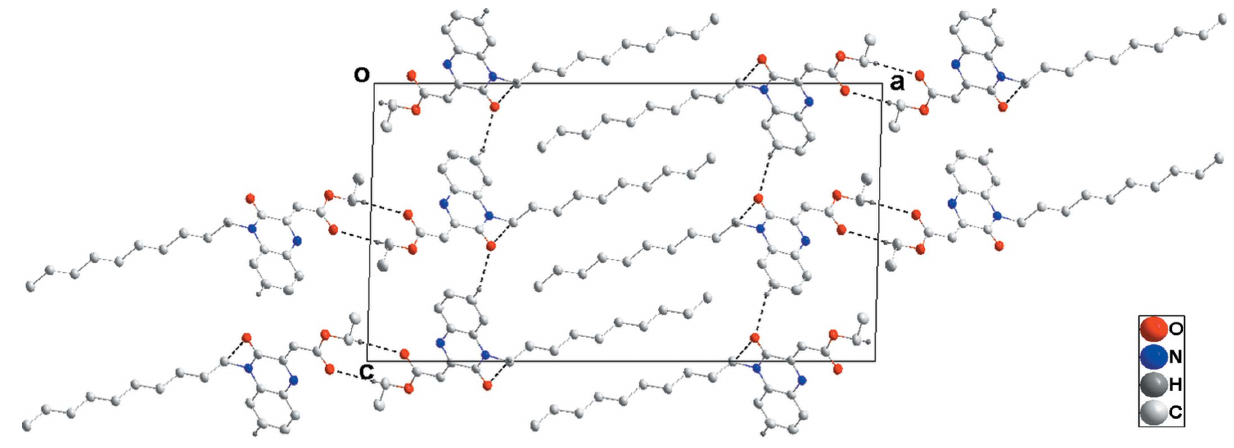
Figure 3 The packing, viewed along the b -axis direction, with C—H (cid:2)(cid:2)(cid:2) O hydrogen bonds shown as dashed